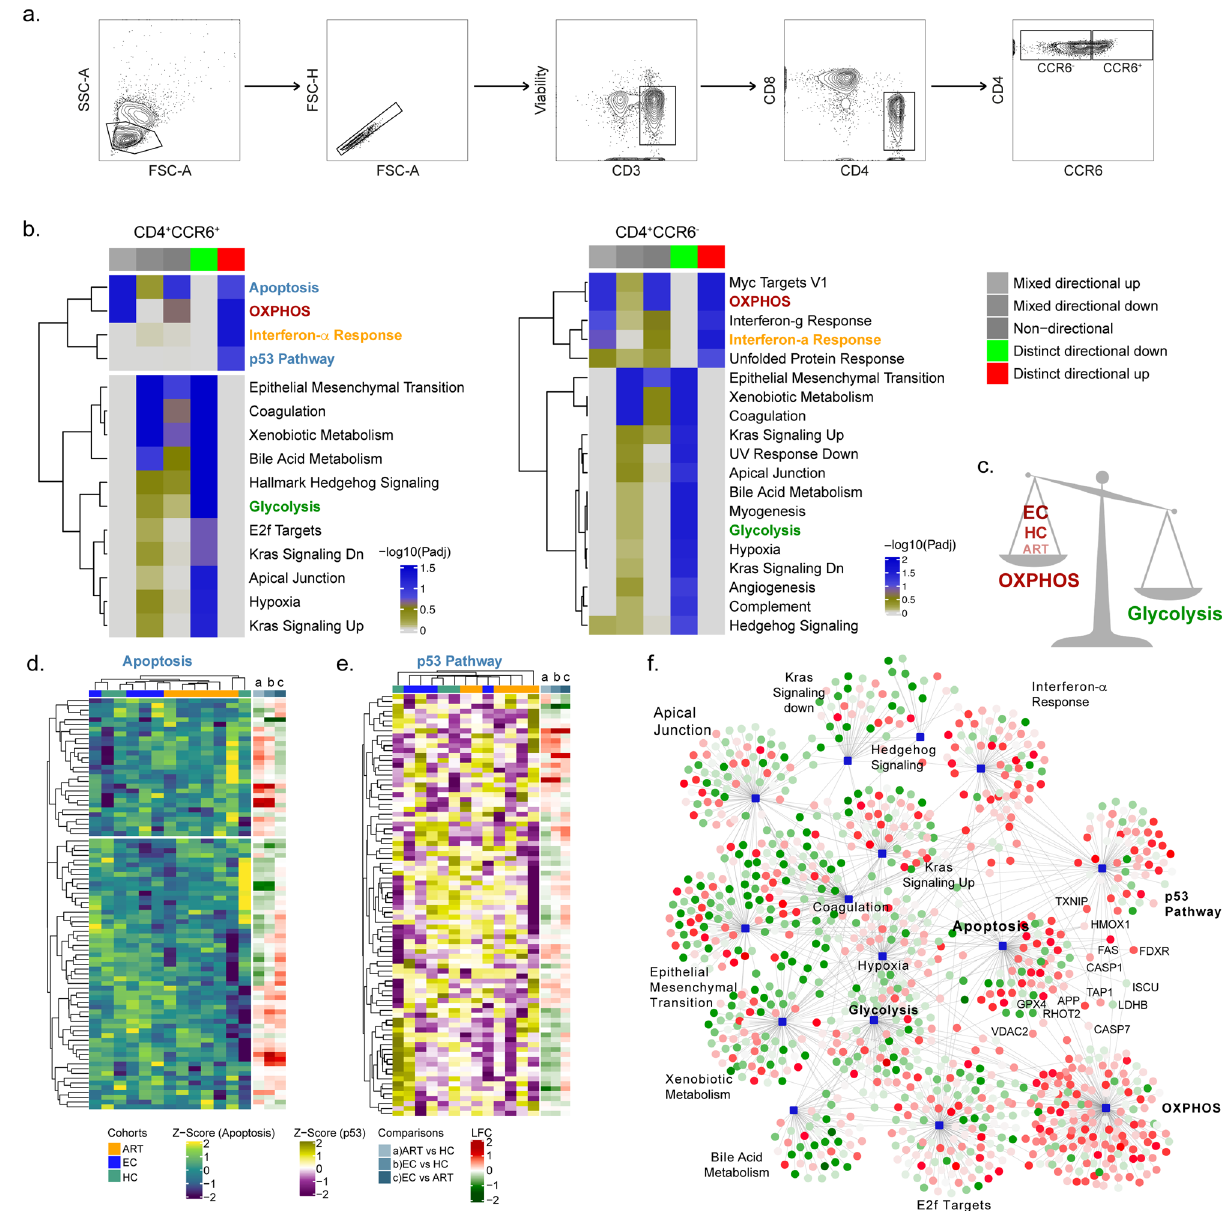
Fig. 5 CD4 + CCR6 + are enriched in proteins from p53 and apoptosis signalling in PLWH EC compared to PLWH ART . Characteristics of CD4 + CCR6 + and CD4 + CCR6 − cell populations isolated by FACS from PLWH EC ( n = 4), PLWH ART ( n = 6) and HC ( n = 3). a Gating strategy for isolation of CD4 + CCR6 + and CD4 + CCR6 − cell populations from total peripheral blood mononuclear cells, exhibited by an HC sample. b Heatmap representation of signi fi cant pathways found deregulated in CD4 + CCR6 + PLWH EC compared to CD4 + CCR6 + PLWH ART and in CD4 + CCR6 − PLWH EC compared to CD4 + CCR6 − PLWH ART using MSigDBv. Colour gradient corresponds to the negative log scaled adjusted p-values. Each column represents p -values of various directionality classes, calculated for the pathways. Non-directional p-values are calculated based on gene-level statistics regardless of the direction of expression. Mixed directional up and mixed directional down p-values are calculated using the subset of the gene statistics that are upregulated and downregulated, respectively. Distinct directional up and distinct directional down p-values are calculated from gene statistics with expression direction. c Schematic representation of metabolic trade-off between OXPHOS and glycolysis detected in the cells. d , e Heatmap representation of proteins part of apoptosis ( d ) and p53 pathway ( e ). Colour gradient corresponds to the z-score scaled normalized expression values. Column annotation represents the cohorts and row annotation visualizes the log2 transformed fold change values in each of the differential expression analysis of PLWH ART compared with HC, PLWH EC compared with HC and PLWH EC compared with PLWH ART . f Network visualization of signi fi cant pathways enriched in CD4 + CCR6 + PLWH EC compared to CD4 + CCR6 + PLWH ART . Each edge represents association of the protein with the corresponding pathways. Circular nodes denote proteins and square-shaped nodes are pathways. Red colour gradient and green colour gradient represent upregulation and downregulation of the proteins in CD4 + CCR6 + PLWH EC compared to CD4 + CCR6 + PLWH ART